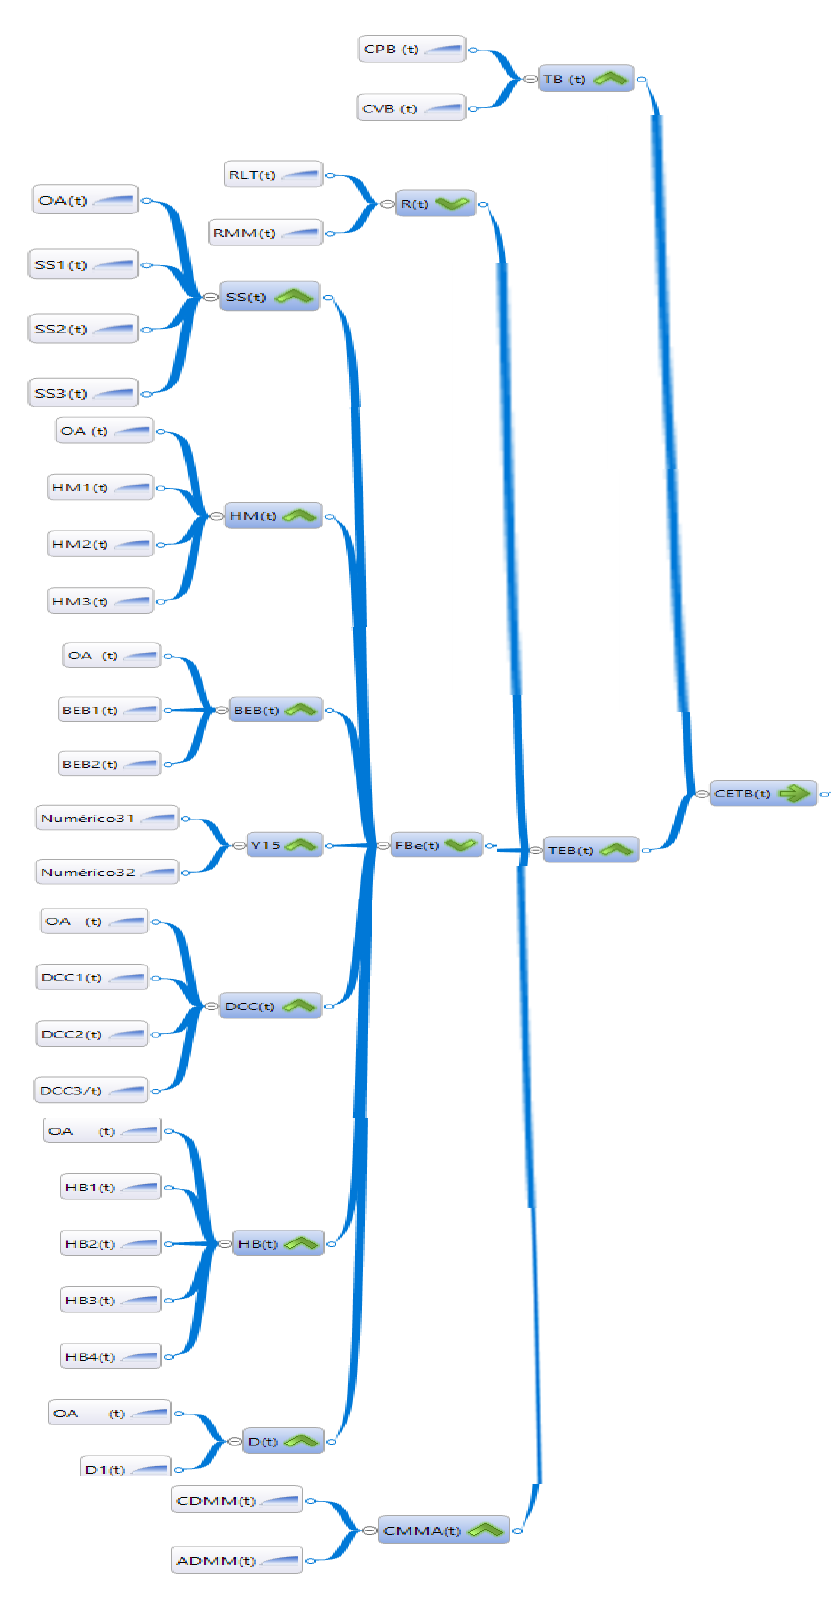
Figure A4. Logical tree representing the truth degree of the composed predicate “there is a bearish scenario at time t ”, CETB ( t ).